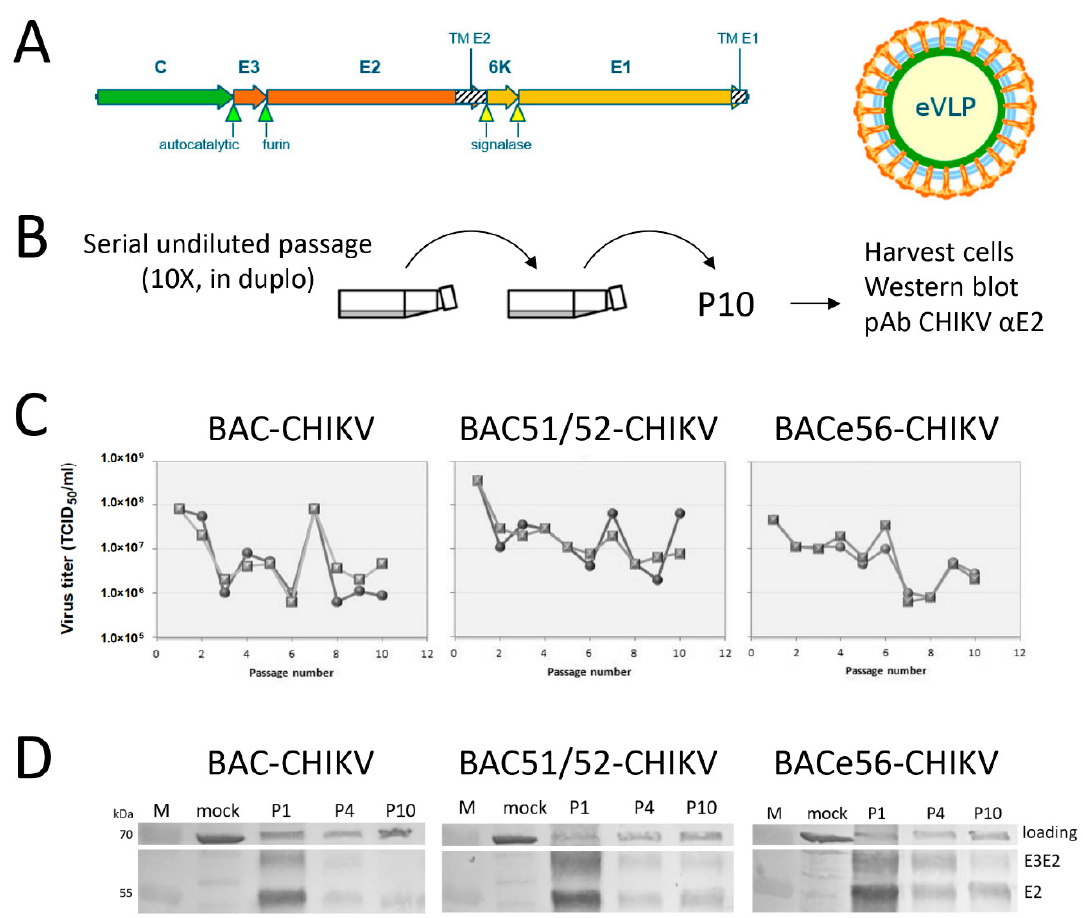
Figure 5. Effect of serial undiluted baculovirus passage on chikungunya virus-like particle (VLP) production. ( A ) Schematic representation of the chikungunya virus (CHIKV) structural genes for insect cell expression of enveloped (e)VLPs using recombinant baculoviruses. Shaded areas represent transmembrane domains. Arrows indicate protease cleavage sites. ( B ) Experimental set-up for serial undiluted baculovirus passage in Sf21 insect cells. ( C ) Viral titers of serial undiluted passaging experiment. Each recombinant baculovirus was passaged in duplicate for 10 passages. Viral titers were determined by end point dilution assay and are expressed as tissue culture infective dose 50% per ml (TCID 50 / mL ). ( D ) Chikungunya VLP expression upon serial passage. Western blots detected with anti-E2 polyclonal antiserum show CHIKV glycoprotein E2 and the precursor E3E2. M: protein marker; loading: host cell protein; mock: healthy